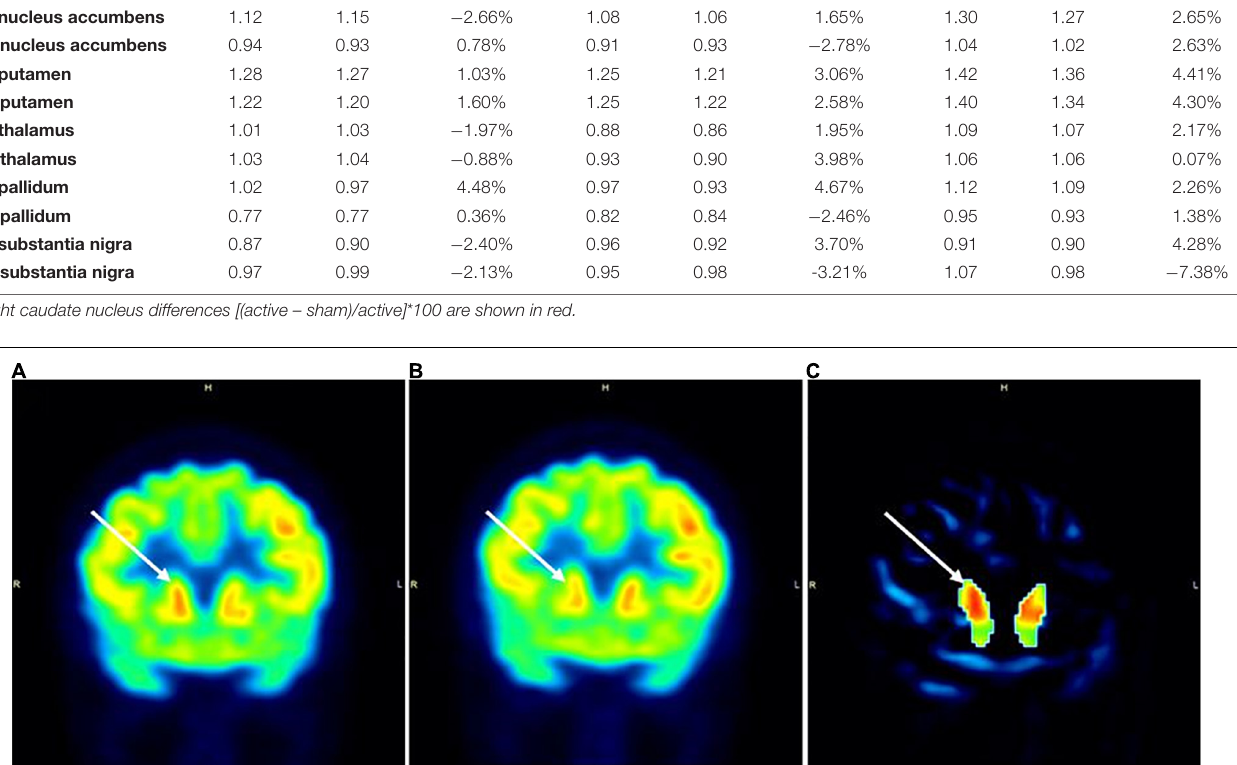
(C3). The treadmill speed was 0.8 mph and her blood glucose was 110 mg/dL (Session 2; active) and 109 mg/dL (Session 3;